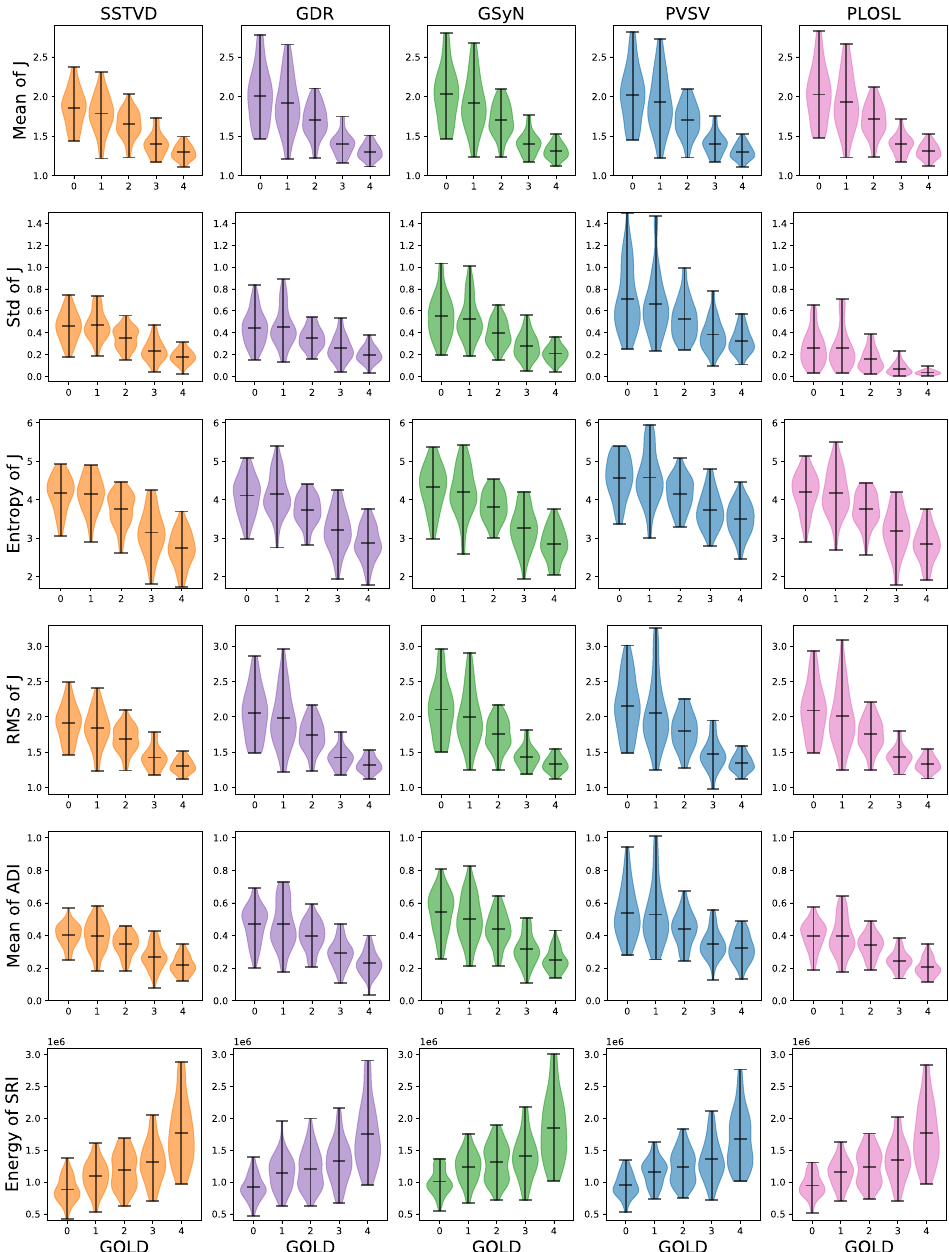
Figure 4. Comparison of biomechanical measures across image registration algorithms as a function of GOLD stages. The measures shown were the only measures to exhibit monotonically increas- ing/decreasing behavior independent of registration algorithms (GOLD: Global Initiative for Chronic Obstructive Lung Disease, SRI: slab-rod index, ADI: anisotropic deformation